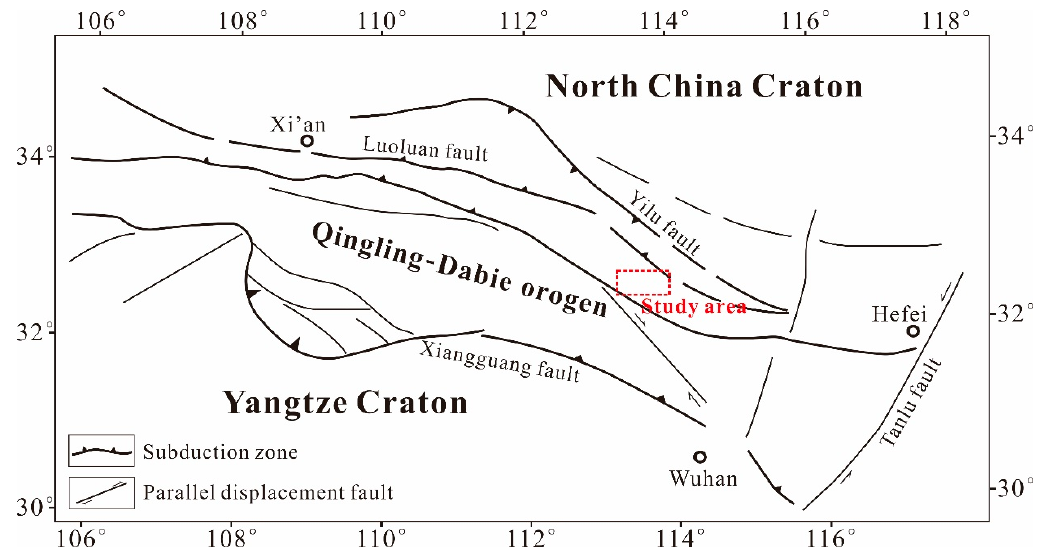
Figure 1. Location and geological map of the Qinling-Dabie orogenic belt (modified from [66]). The Laowan gold deposit is located in the East of the Qinling-Dabie orogenic belt and the Laowan ductile shear zone. The Northern and Southern sides are bounded by the Laowan and the Songpa ductile shear belt. The main host rock of the Laowan deposit is a metamorphic rock series from the Guishan Formation of the middle Mesoproterozoic period, which has undergone many ductile and brittle shear activities (Figure 2). The lithology is mainly mica-quartz schist and plagioclase-hornblende schist, and mylonitic silicified rocks [53,54,58,67]. The original rocks are basic volcano-clastic sedimentary [53].